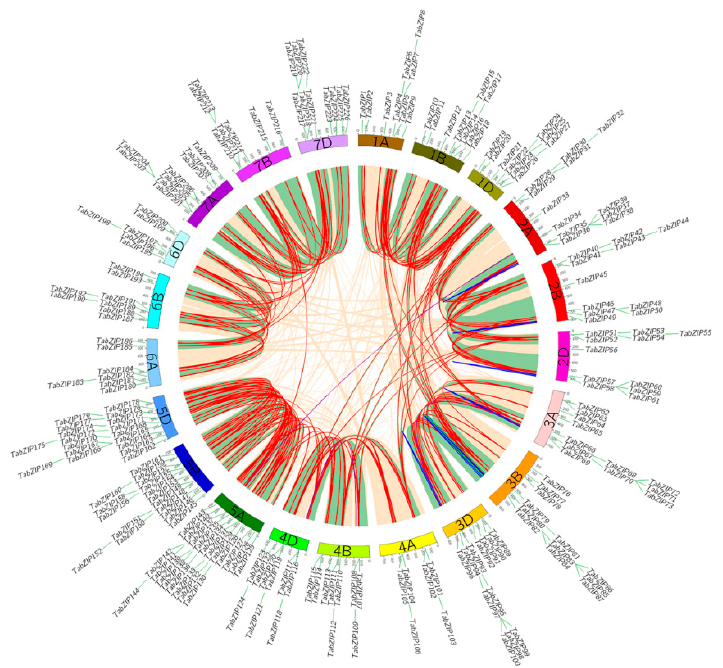
Figure 4. The syntenic pairs of wheat TabZIP genes from different duplication mode diagrams. Syntenic pairs from different duplication modes were linked by corresponding color lines. Red, blue, purple, and green represent syntenic regions with segmental, tandem, transposed, and proximal duplication. Others syntenic pairs genes were shown with pale yellow lines.